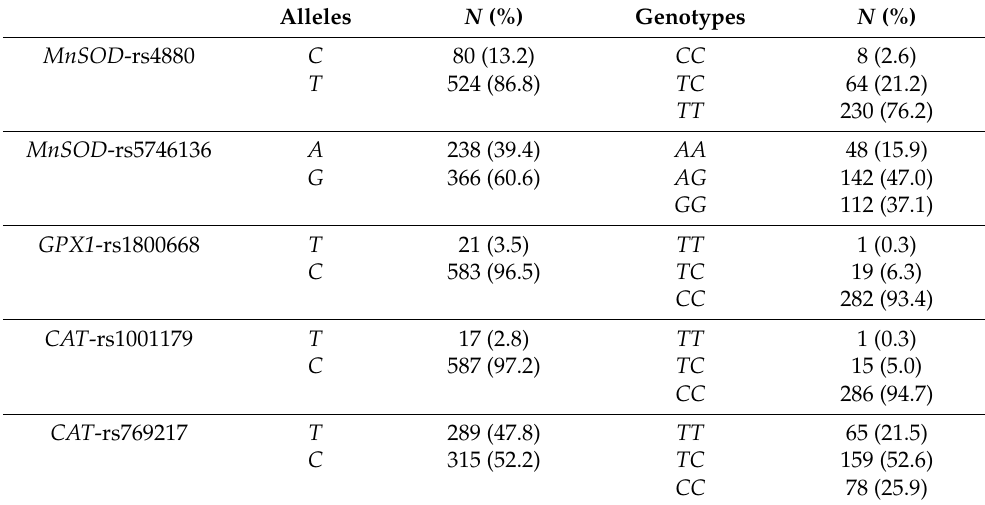
Table 2. Distribution of SNPs of antioxidant enzyme genes ( MnSOD, GPX1, and CAT ) in 302 calcium urolithiasis patients.